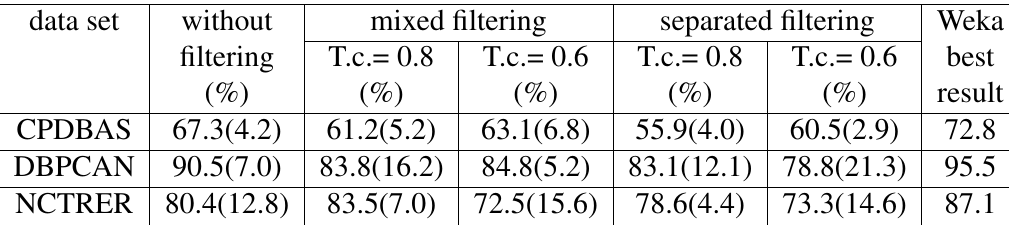
Table 2: Accuracy and standard deviation (in parenthesis). T.c. is the Tanimoto coefficient.